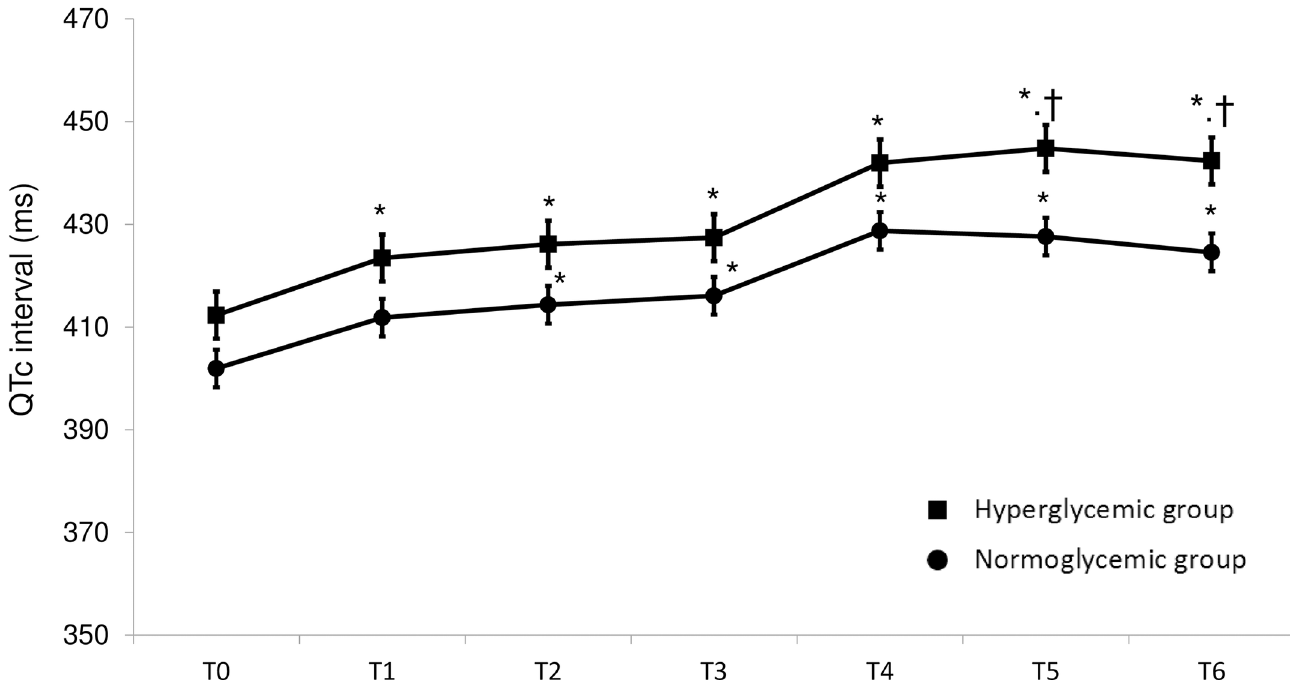
Fig 2. Mean QTc intervals ( ± SE; milliseconds) versus measurement time points before and after sevoflurane administration in the chronically hyperglycemic group (closed squares) and in the normoglycemic group (closed circles). The values recorded before the administration of sevoflurane (T0) and at 5 (T1), 10 (T2), 30 (T3), 60 (T4), 90 (T5), and 120 (T6) min after the administration of sevoflurane are shown. * P < 0.05 comparedwith the baseline(pre) value; †P < 0.05 comparedwith the normoglycemic group.